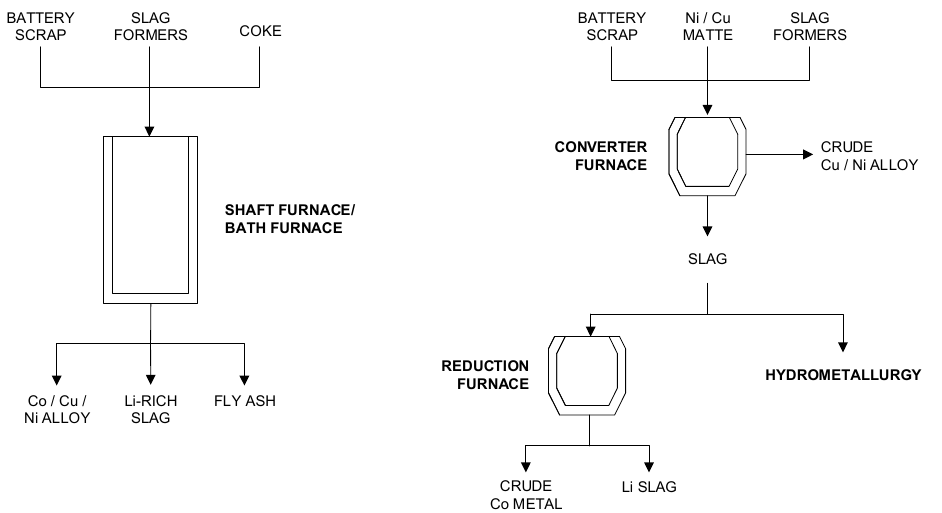
Figure 6. Simplified flowsheets of the two different processes published by Umicore SA based on [54–57].